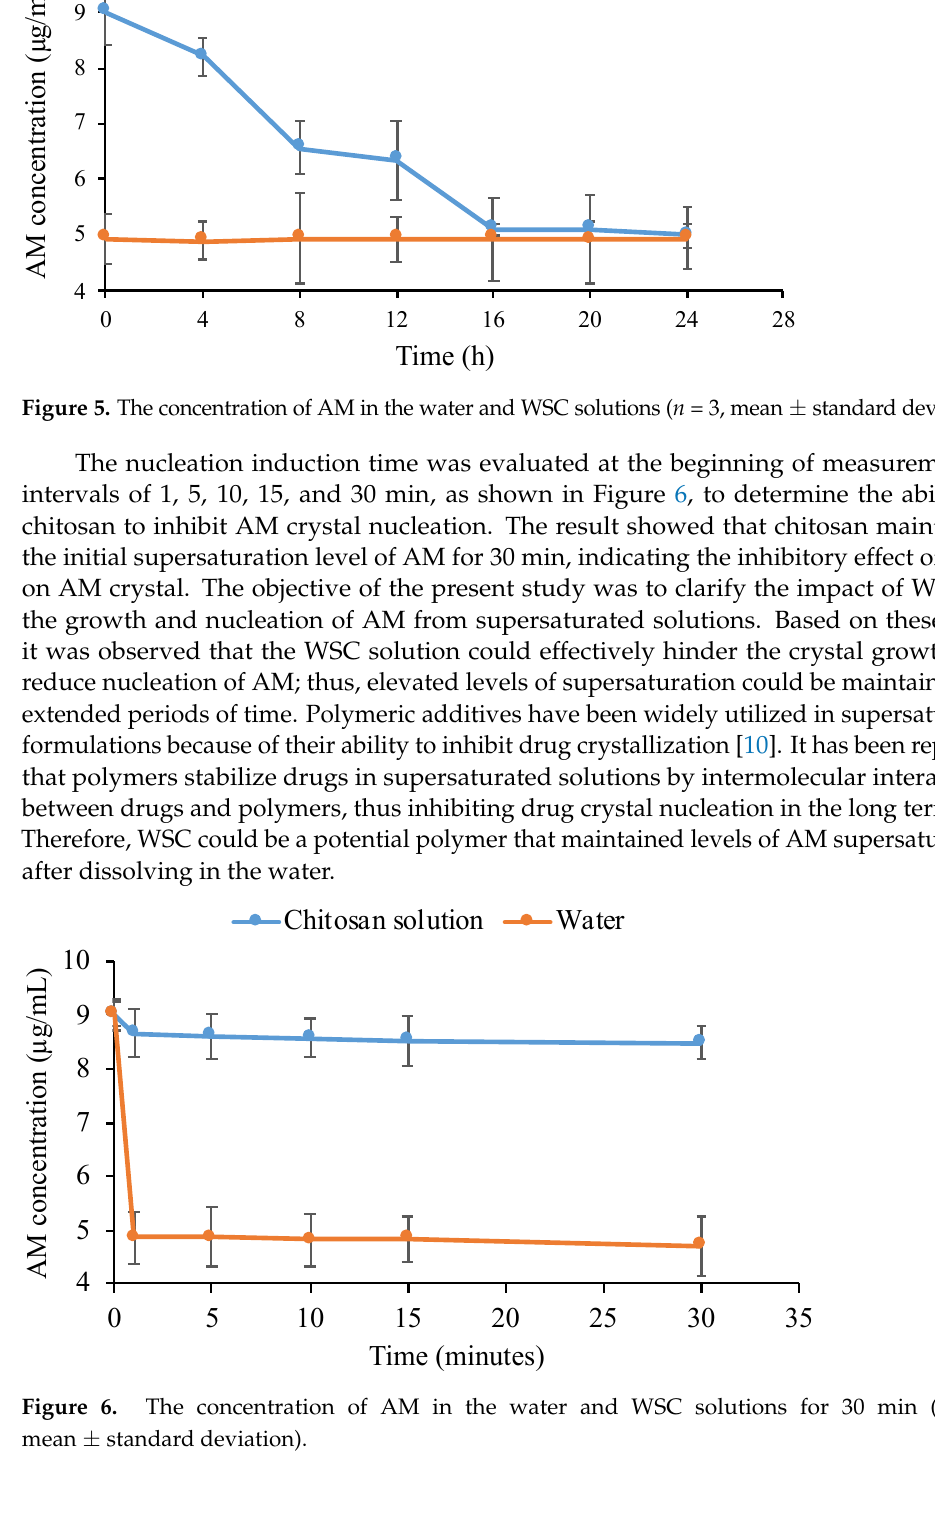
6 of 13 Figure 4. Crystalline solubility of AM at 25 °C in WSC solution with various concentrations. 3.2. Nucleation Induction Time Measurements In the crystallization kinetics of the drug, the time required for the drug to form crit- ical nuclei from the supersaturated solution is called nucleation time. Determination of drug crystal nuclei experimentally is not possible until a detectable size is achieved. There- fore, induction time is measured to describe the time required for the drug to form an observable change in the crystallization system from the starting point of drug supersat- uration. It can be measured experimentally to describe the time required for the formation